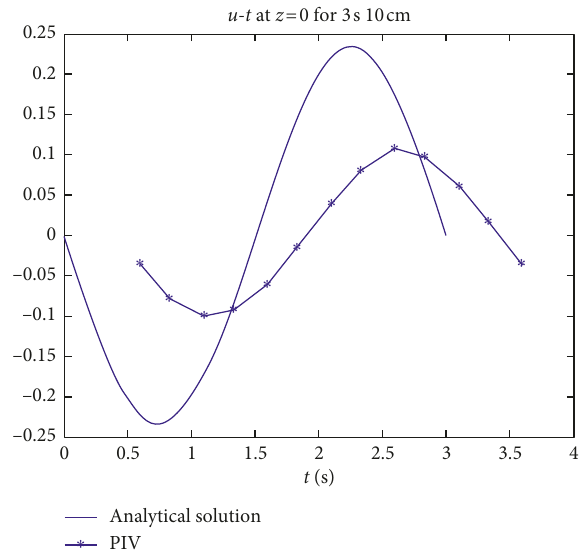
10cos(2 t/6); (b) f 0 f s (cid:31) π −